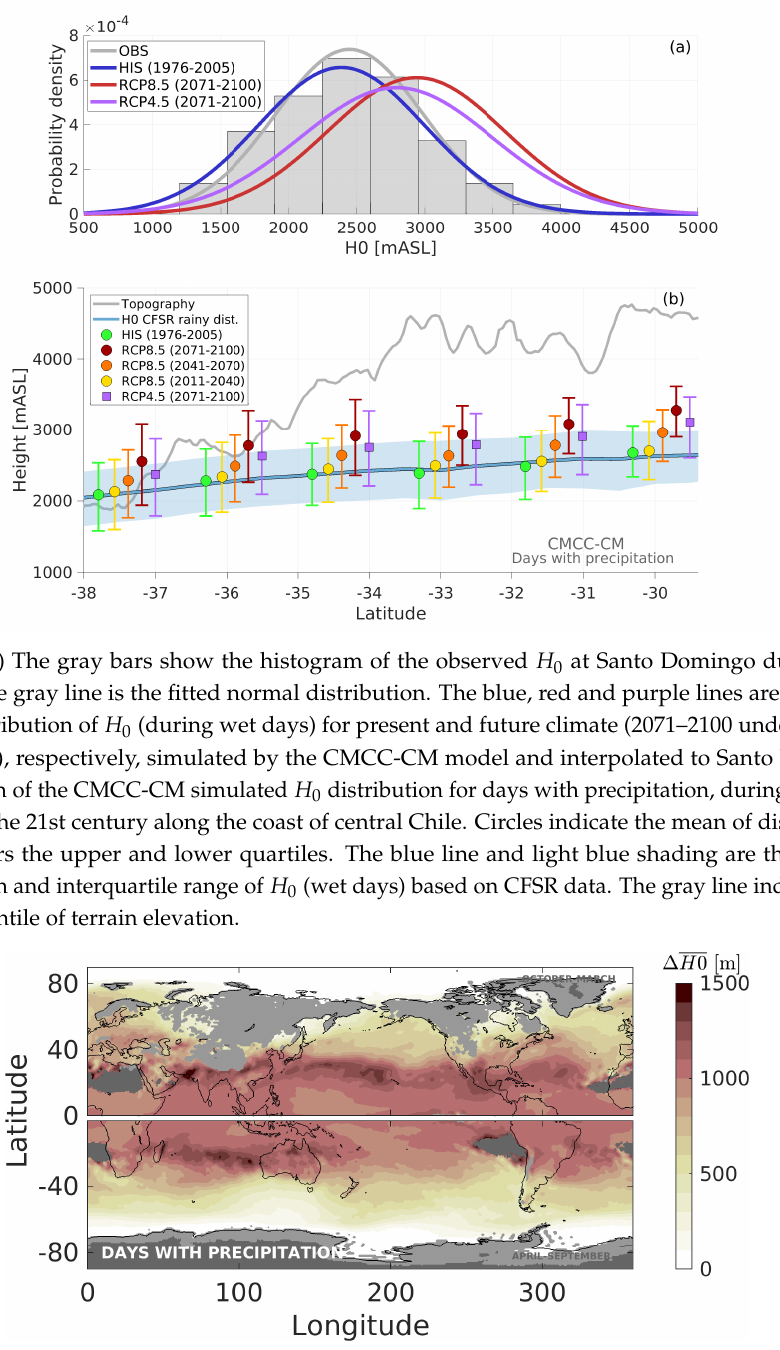
Figure 6. Global distribution of the difference in mean H 0 between the end of century (2071–2100 under scenario RCP8.5) and the historical period (1976–2005) simulated by the model CMCC-CM for winter days with precipitation. The winter months are October–March in the Northern Hemisphere and April–September in the Southern Hemisphere. Light gray areas represent those regions where mean H 0 intersects the topography. Dark gray areas indicate arid regions where the low number of rainy days precludes a robust calculation of H 0 under wet